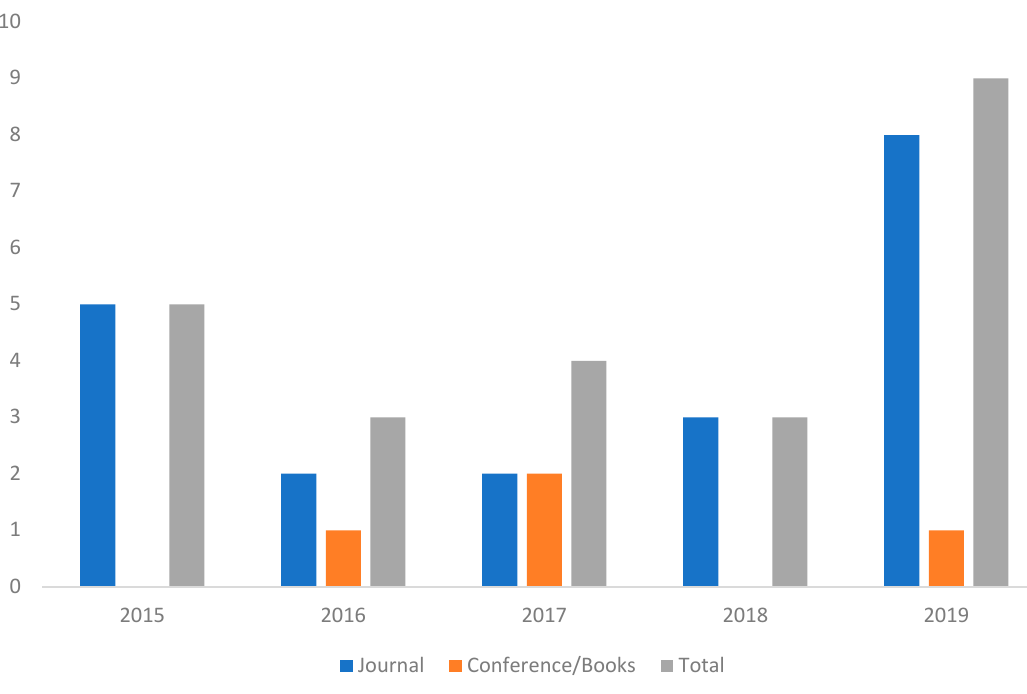
Table 2. Documents used to construct the conceptual framework.